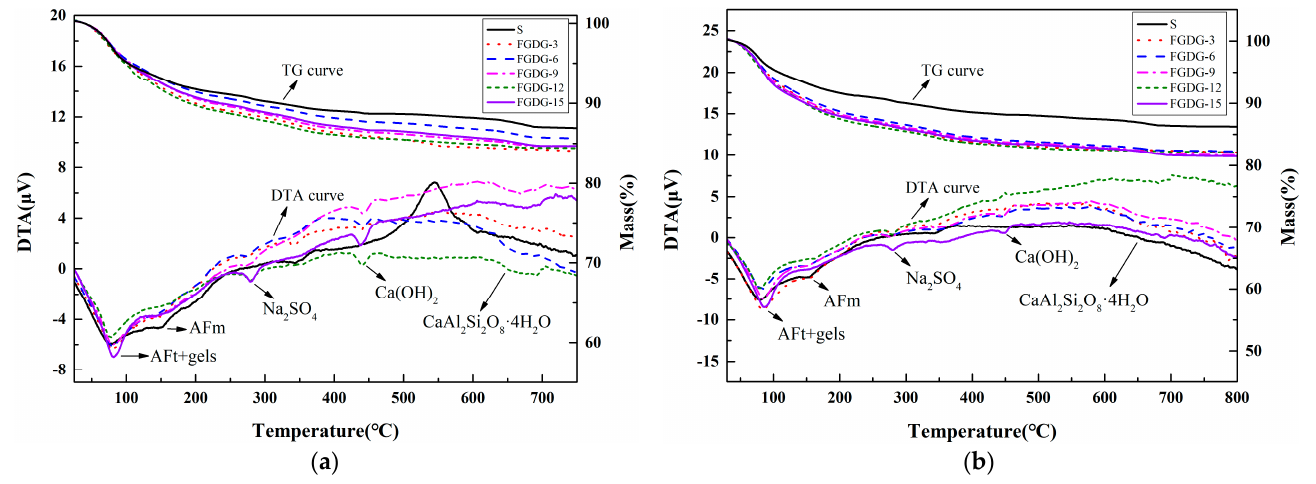
Figure 11. TG-DTA results of cement paste with different FGDG content: ( a ) 3 days; ( b ) 28 days.